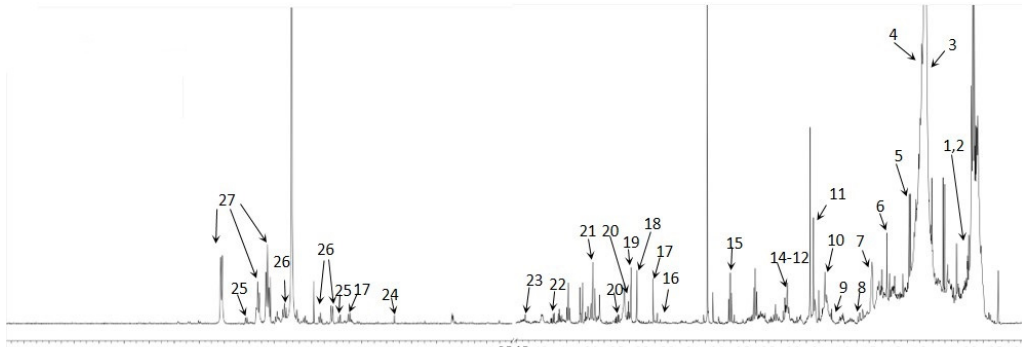
Figure 2. 1 H-NMR 600 MHz Carr–Purcell–Meiboom–Gill (CPMG) spectra of urine obtained from non-polar phase sample (CDCl 3 , T = 300 K); 1 —Cholesterol ester, 2 —Terminal -CH 3 , 3 —Acyl chain C4-C7,